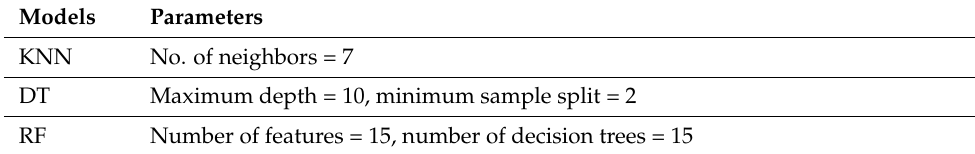
Table 4. Parameters for ML Models.